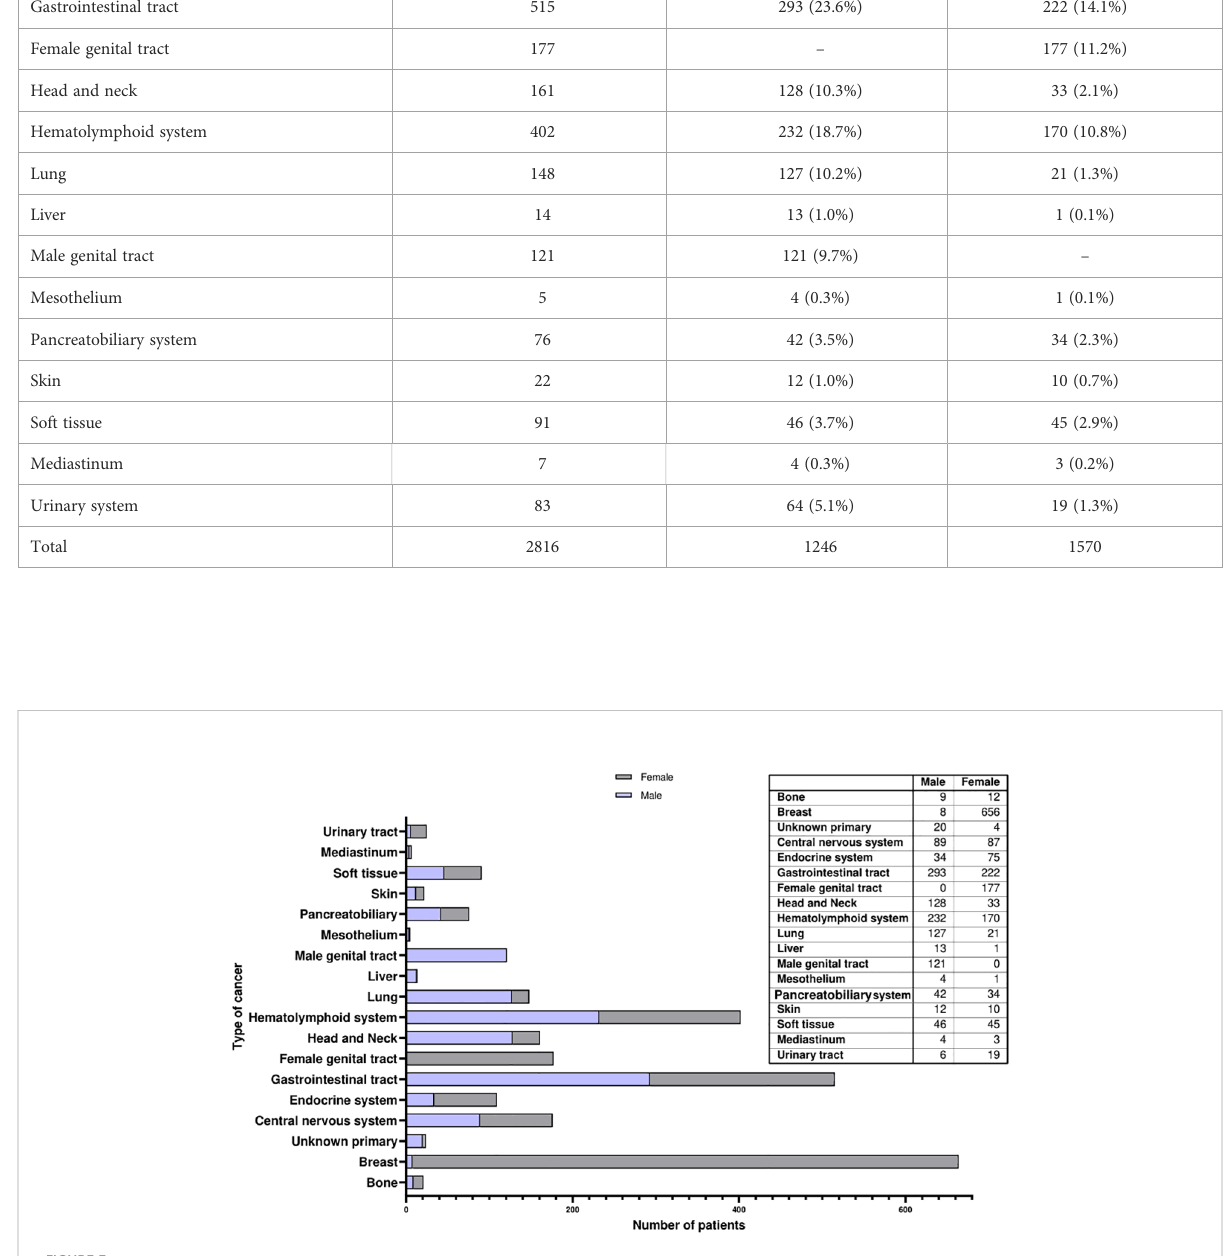
FIGURE 3 Gender-based strati fi cation of adult